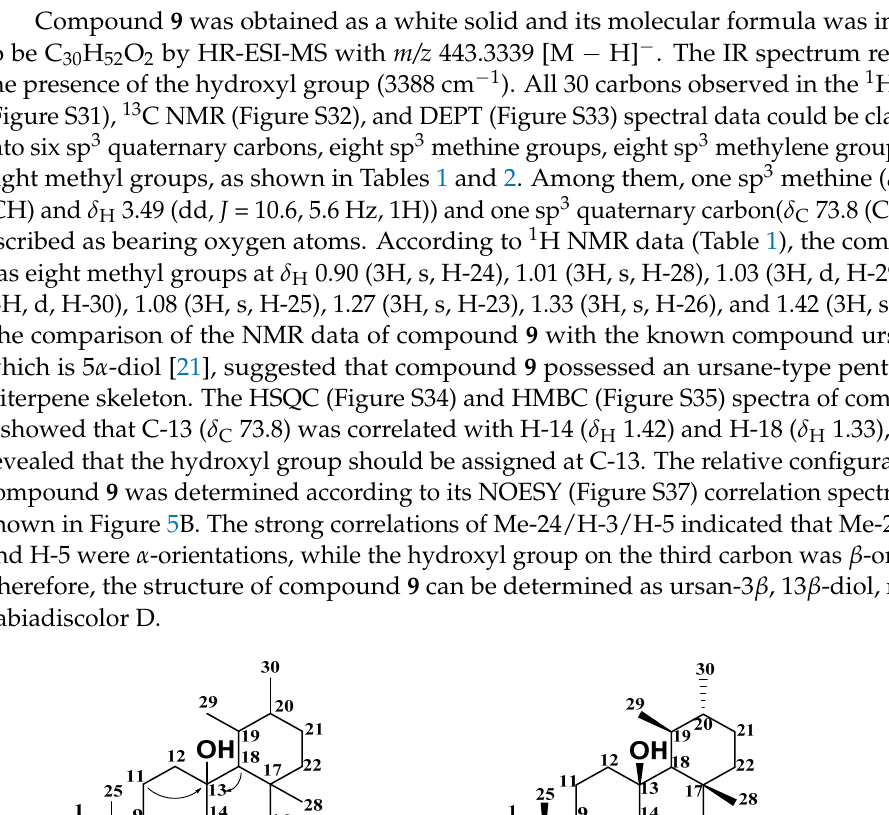
Figure 4. Key HMBC (plain arrow; A ) and NOESY (dash arrow; B ) correlations of compound 8 .